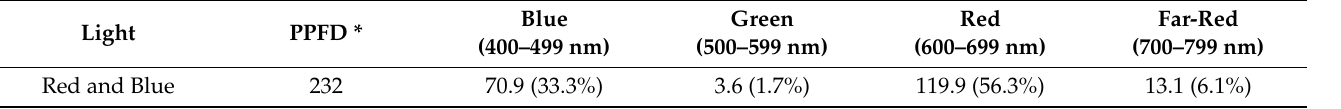
Figure 1. Relative spectral distributions of the red and blue LED light used in this study. Table 1. Summary of the spectral qualities tested for the red and blue light (RB) ( µ mol · m − 2 · s − 1 ).